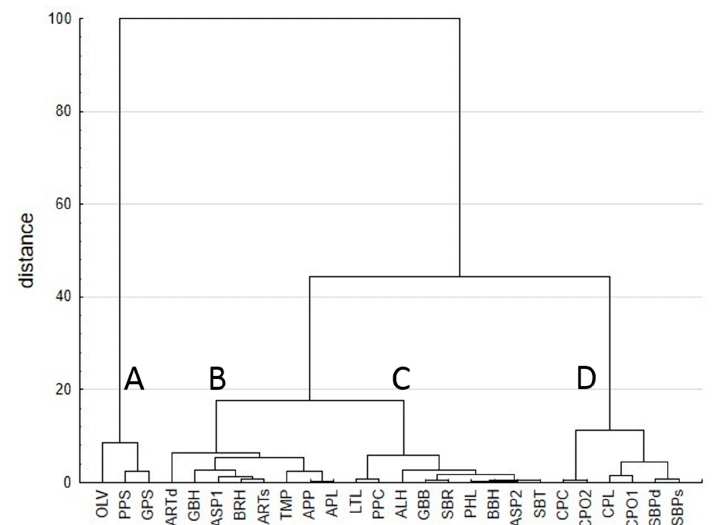
Figure 1. Multivariate cluster analysis plot showing groups of different by-products based on similarities in chemical composition, in vitro digestibility and fermentation kinetics: OLV (olive tree leaves), PPS (pepper skins), GPS (grape seeds), ARTd (hay of artichoke by-products), GBH (green bean haulms), ASP1 (asparagus rinds 1), BRH (broccoli stalk hay), ARTs (ensiled artichoke by-products), TMP (dried tomato pulp), APP (apple and pear pomace), APL (apple pomace), LTC (lettuce leaves), PPC (pepper cores), ALH (almond hulls), GBB (green bean haulms and sugar beet pulp), SBR (sugar beet rootlets, hairs, root tips and beet tails), PHL (pea haulms), BBH (broad bean haulms), ASP2 (asparagus rinds 2), SBT (sugar beet tops and leaves), CPC (clementine pulp), CPO2 (orange pulp 2), CPL (lemon pulp), CPO1 (orange pulp 1), SBPd (sugar beet pulp dehydrated) and SBPs (ensiled sugar beet pulp). Animals 2019 , 9 , x FOR PEER REVIEW